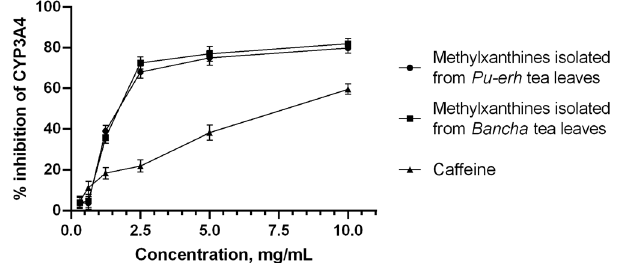
Figure 2. Concentration-dependent inhibition of CYP3A4 by the methylxanthine fractions. Data are presented as mean values ± S.D. of n = 6 independent experiments.